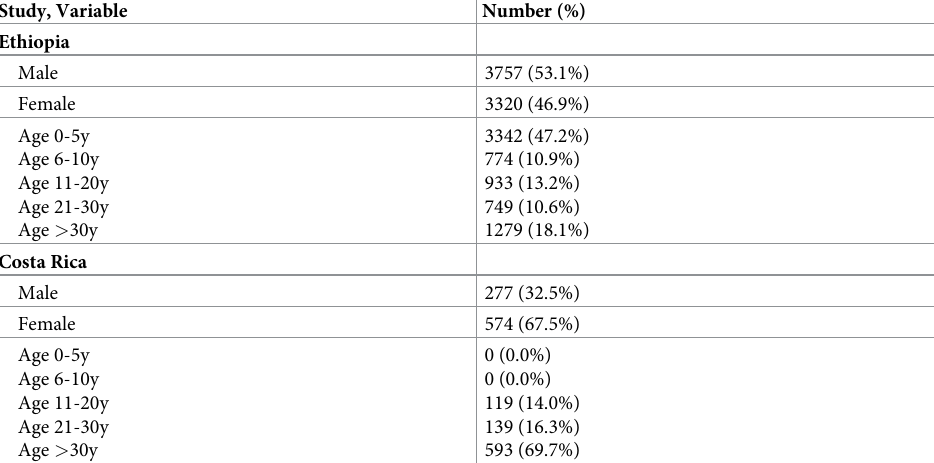
Table 1. Demographic characteristics of the Costa Rica and Ethiopia study